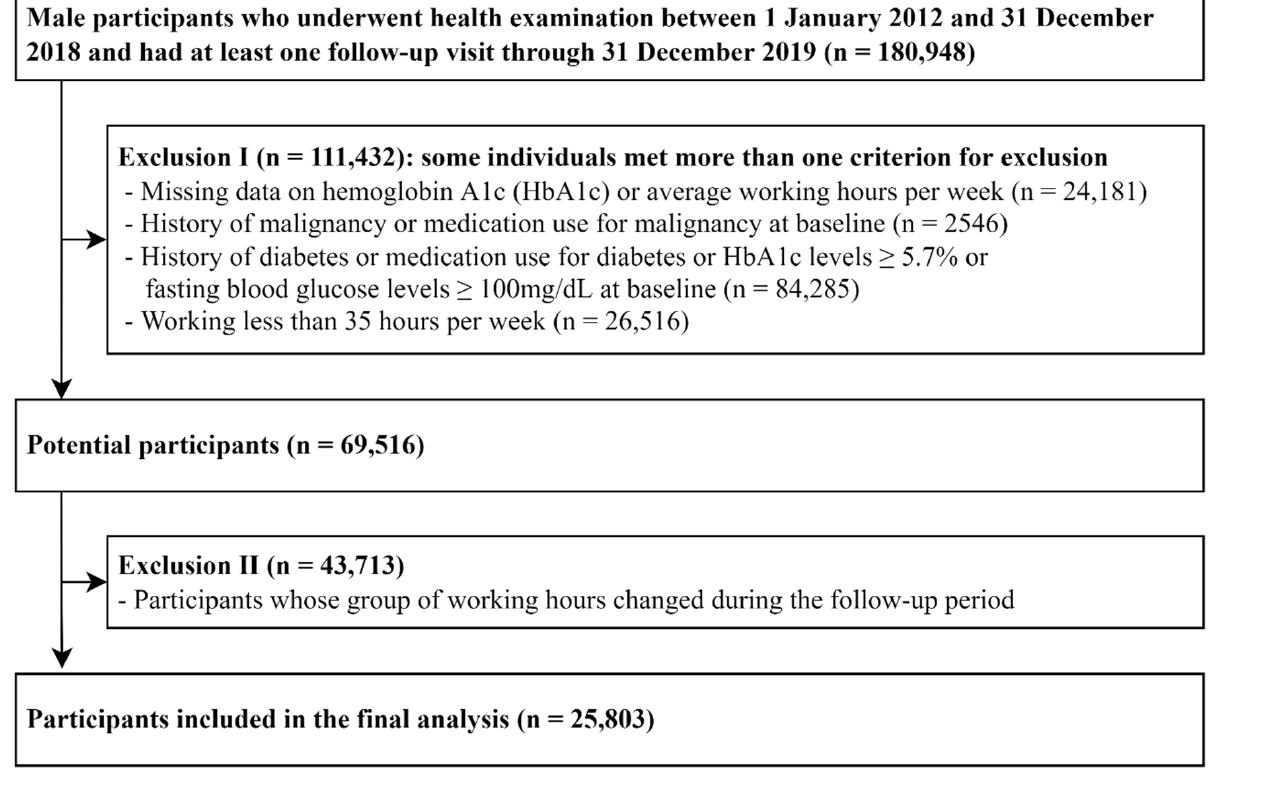
Figure 1. Flowchart of study participants.